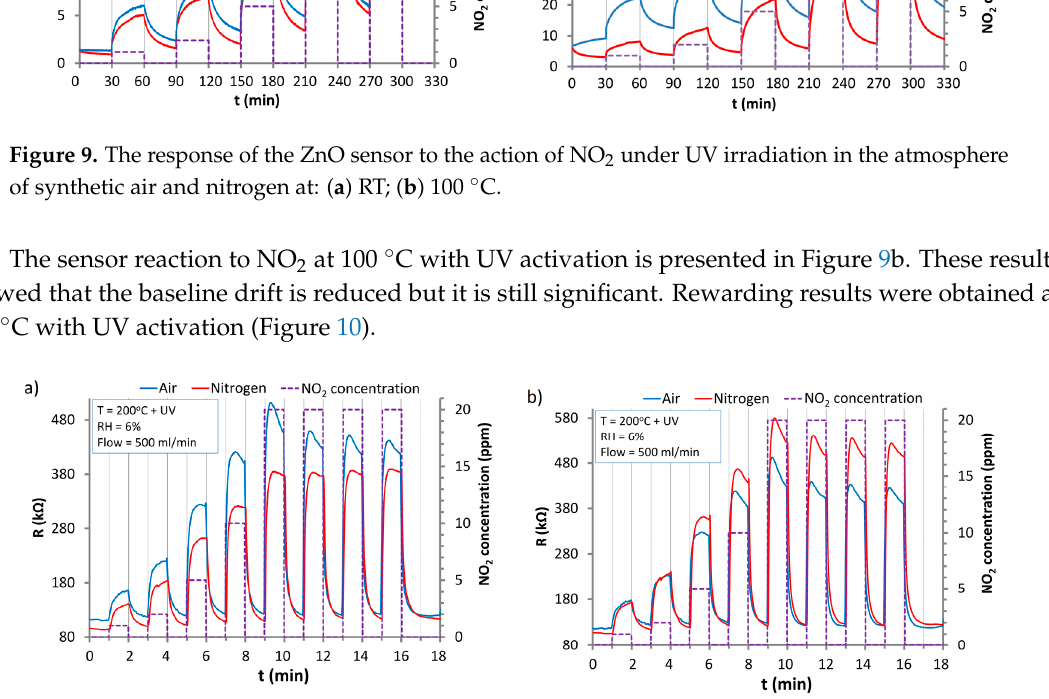
Figure 10. The responses of the ZnO sensors to the action of NO 2 under UV irradiation in the atmosphere of synthetic air and nitrogen at 200 °C: ( a ) Sensor 1; ( b ) Sensor 2.